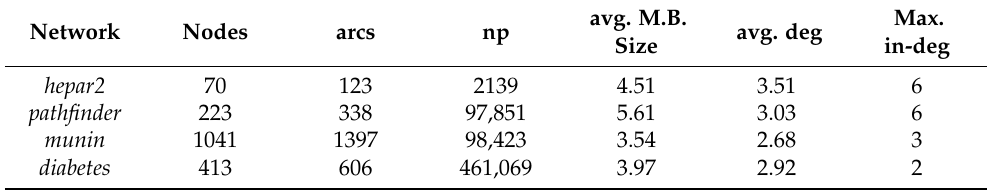
Table 5. Bayesian network